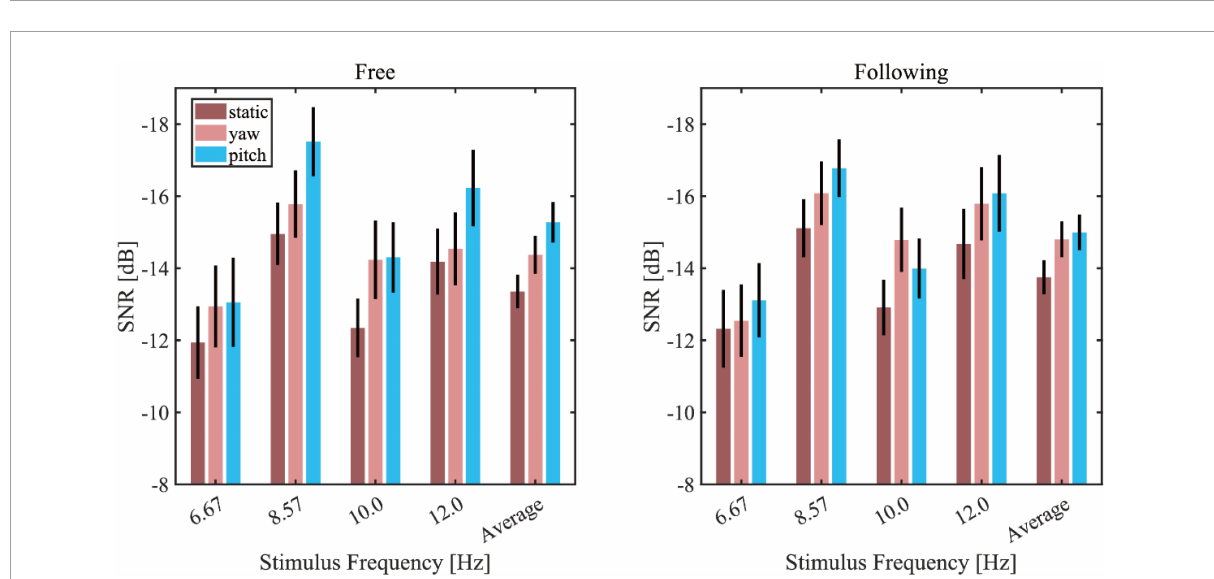
FIGURE6 Wide-band signal-to-noise ratio (SNR) bar plot in different moving tasks, patterns, and stimuli (left column: free moving task; right column: the following moving task).